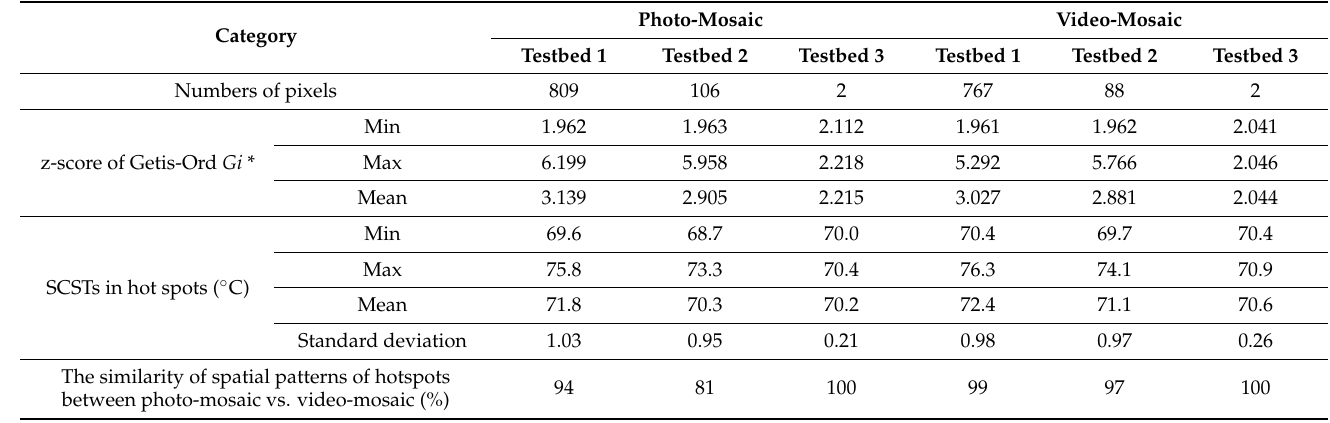
Figure 4. Hot spot boundary on solar cells malfunctioning due to soil debris. ( a1 ): Hot spot boundary (derived from photo-mosaic) overlaid on-field photo; ( b1 ): Hot spot boundary (derived from video-mosaic) overlaid on-field photo; ( a2 ): Hot spot boundary detected from photo-mosaic; ( b2 ): Hot spot boundary detected from video-mosaic. The quadrangle (black box) represents the magnified portion presented in Figure 5. Table 4. Results of the hot spot analysis (Getis-Ord Gi ). The similarity is calculated by dividing hot spots by the matched numbers of hot spots between the photo-mosaic and video-mosaic.